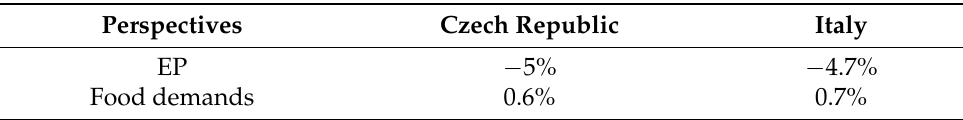
Table 2. Changes in energy and food demand during the COVID-19 outbreaks in Italy and the Czech